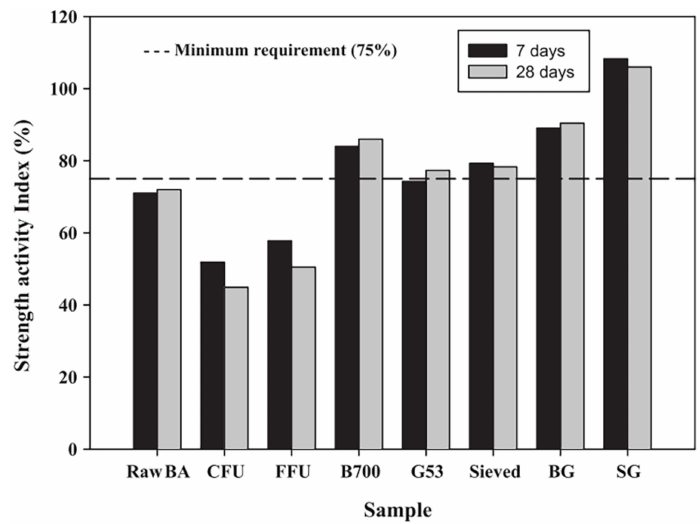
Figure 9. Comparison of SCBA SAI values with different processing methods. Reproduced with permission from